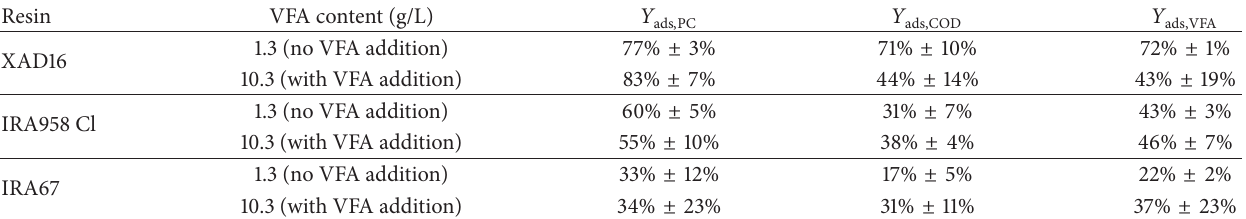
Table 4: Single-point adsorption test: pH-averaged adsorption yields relative to the 3 tested resins, with standard deviations. Resin VFA content (g/L) 𝑌 ads ,